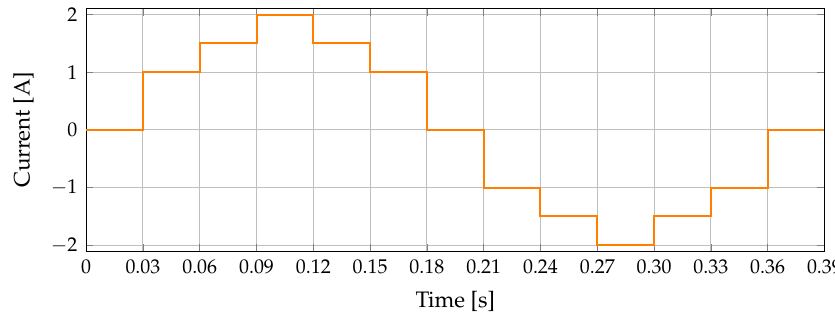
Figure 3. Variations in the input signal i bus .